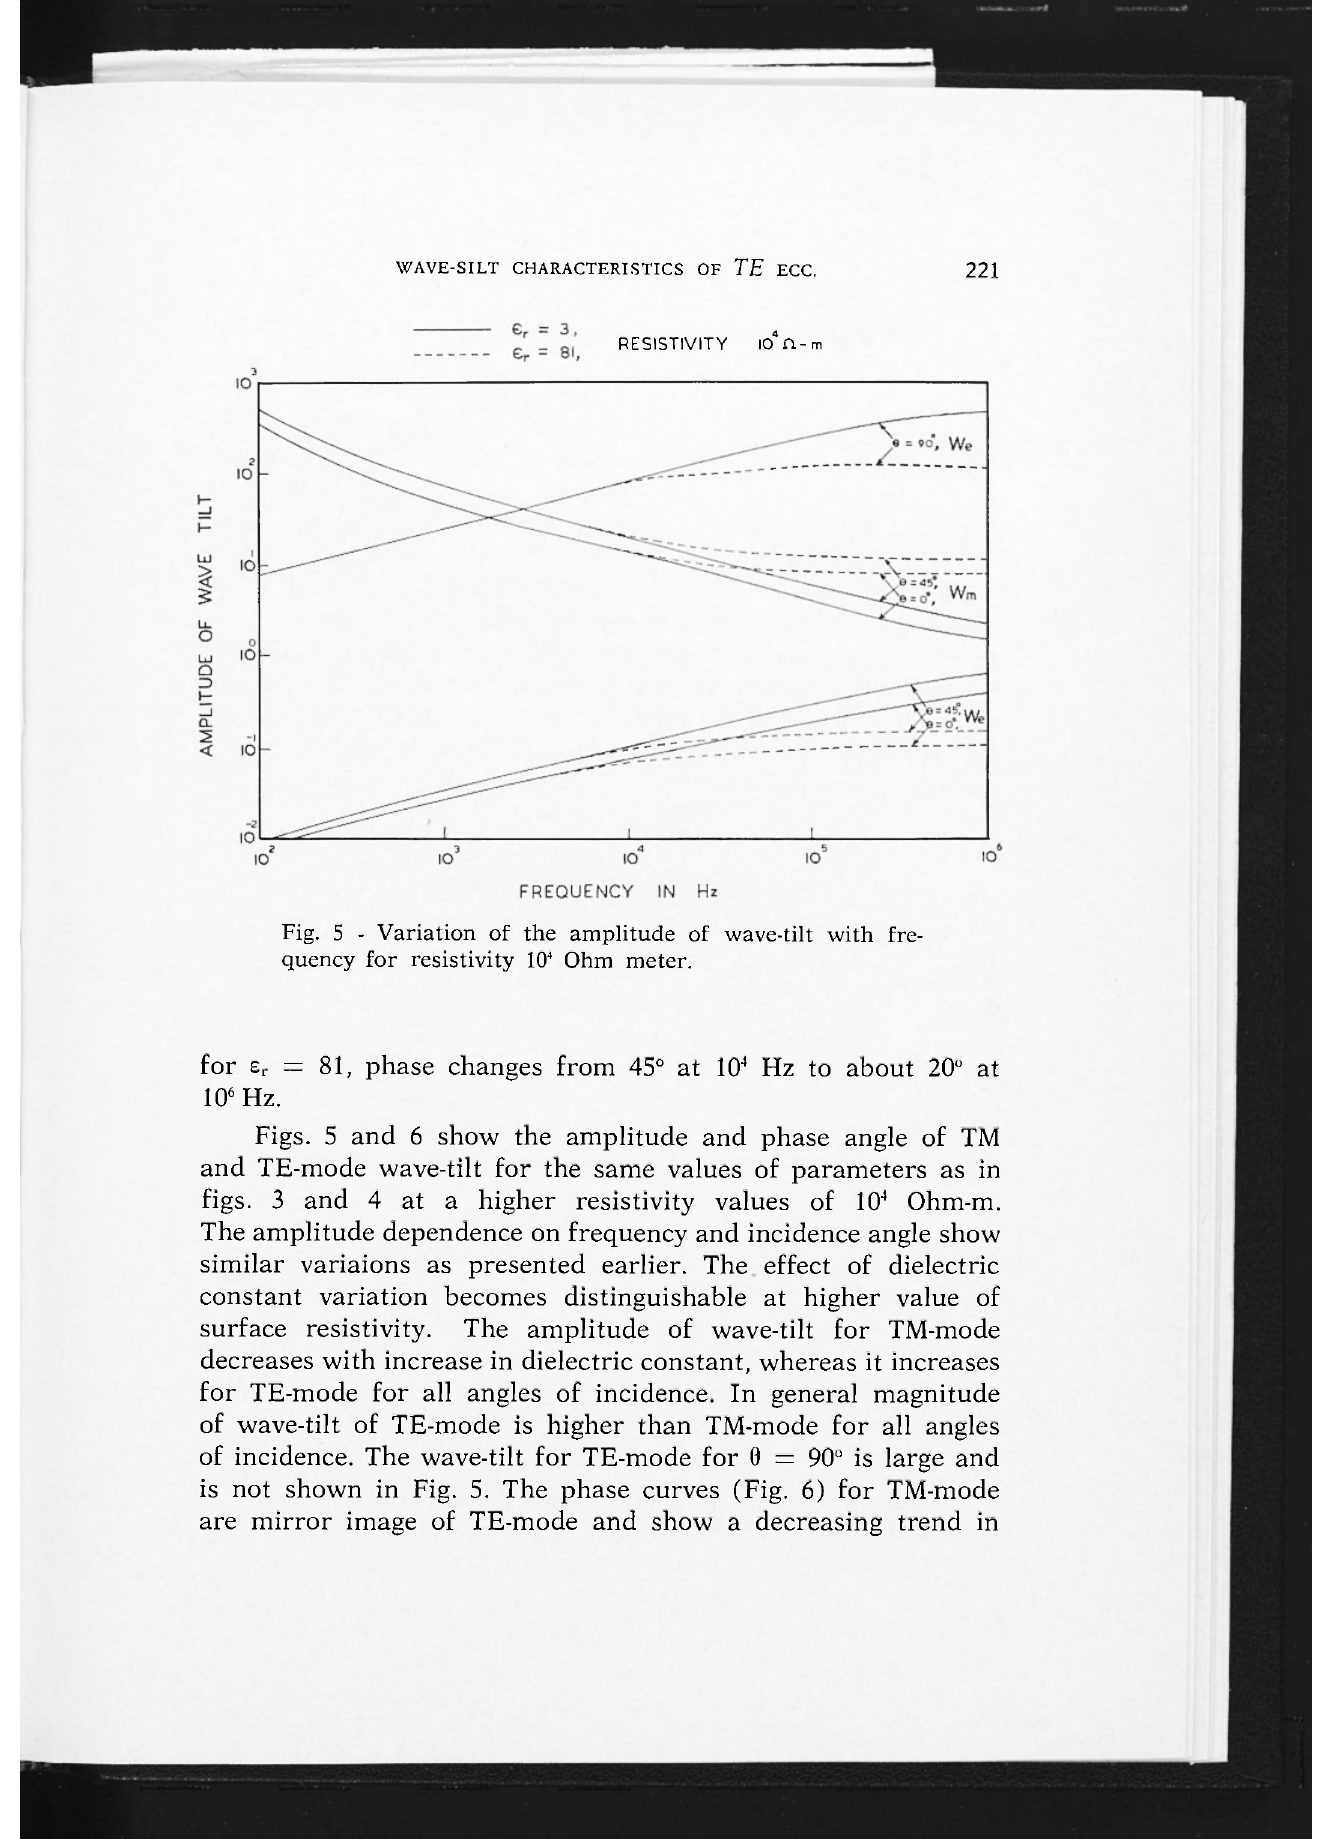
Fig. 5 - Variation of the amplitude of wave-tilt with fre- quency for resistivity 10 4 Ohm